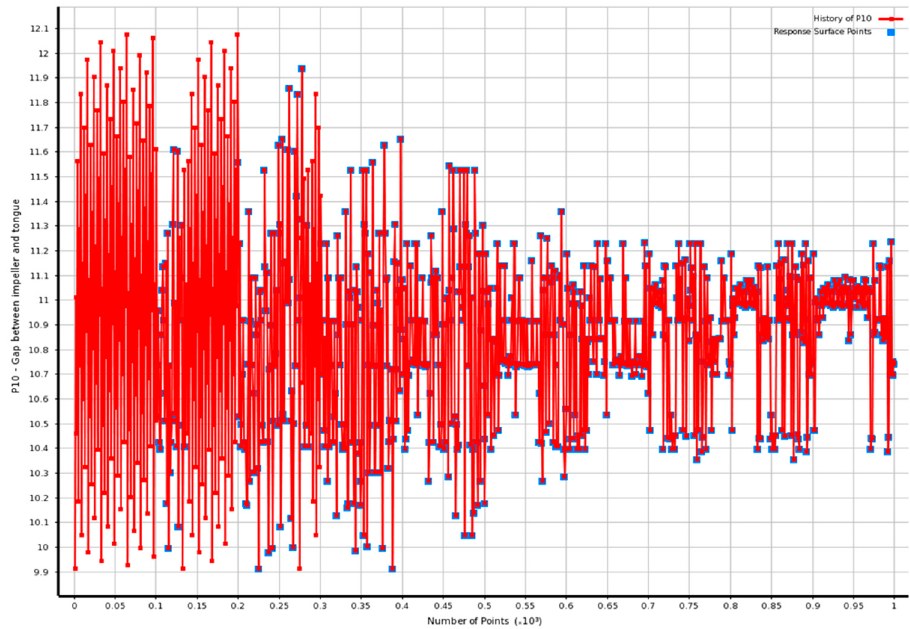
Figure 16. The number of points of tongue length.